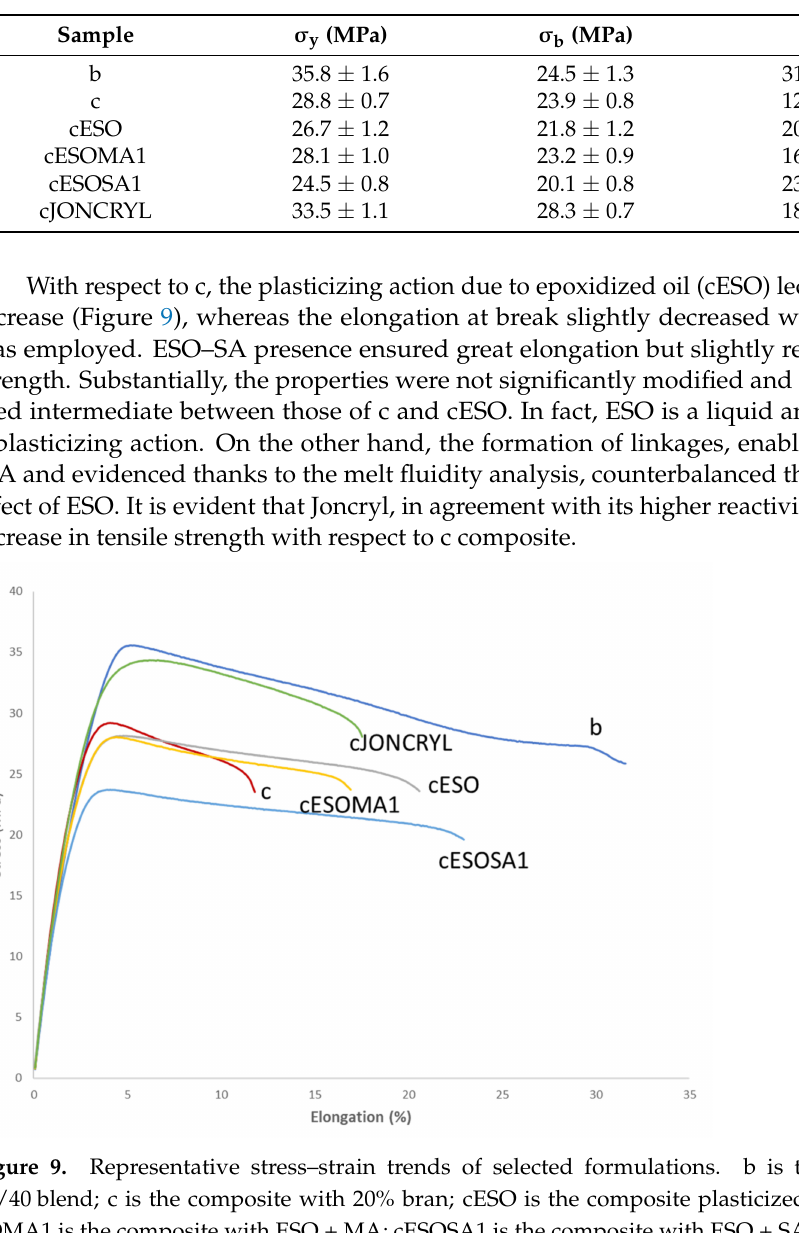
Table 5. Mechanical parameters of the selected formulations.